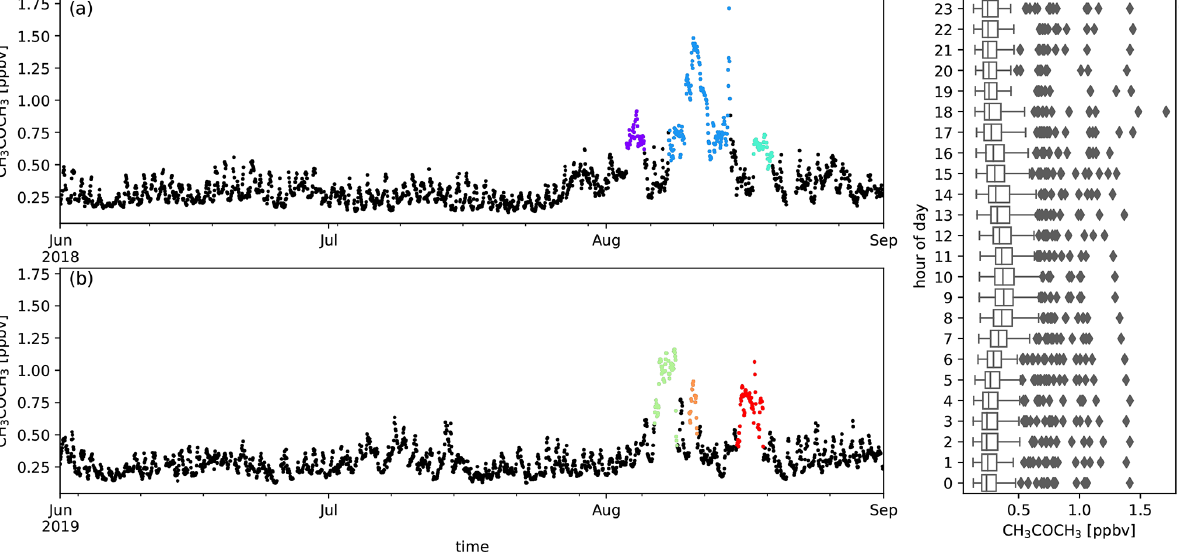
Figure A5. Measured CH 3 COCH 3 mixing ratios (ppbv) during austral winter 2018 (a) and austral winter 2019 (b) together with the diel distribution of hourly averages (c) . Biomass burning plumes under investigation are highlighted in